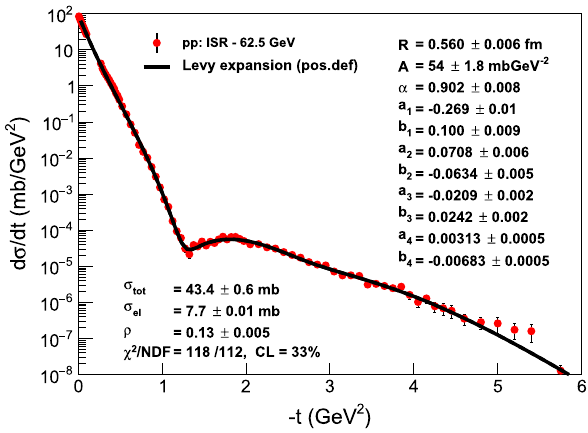
√ s = 53 GeV [46], with fixed